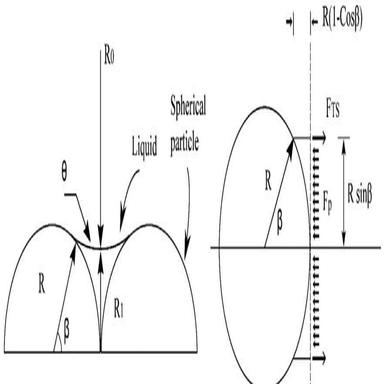
Capillary effect between two particles.